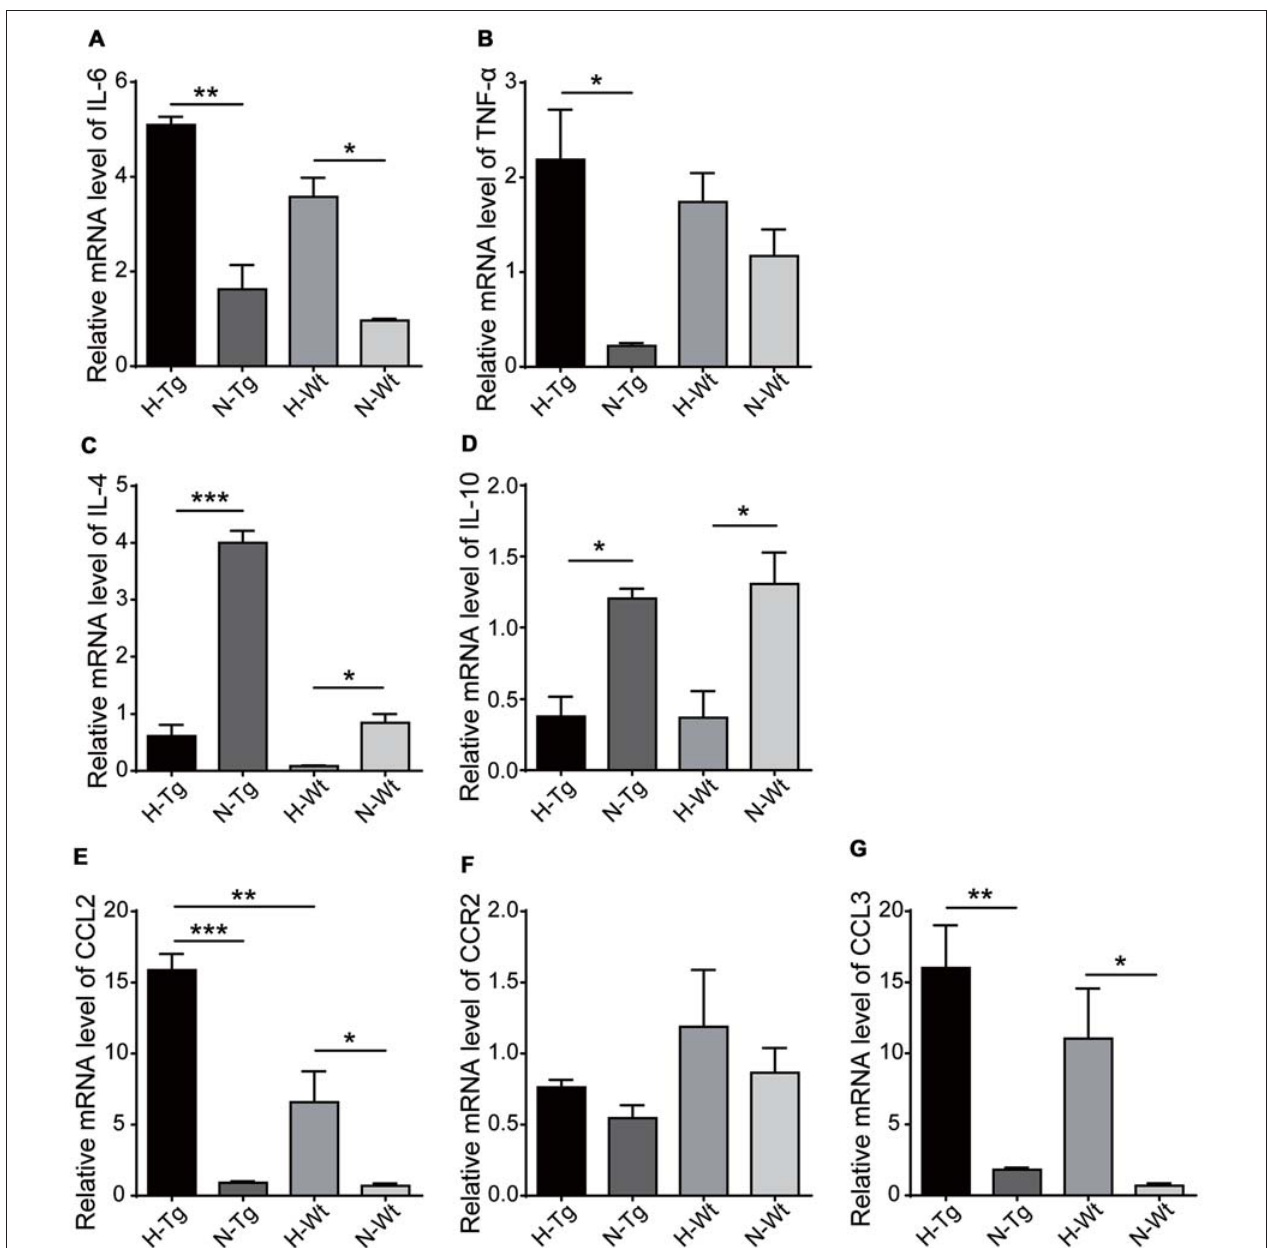
FIGURE 6 | mRNA levels of cytokines and chemokines were detected by real-time PCR in hippocampus after acute hypoxic treatment. Pro-inflammatory cytokines interleukin-6 (IL-6) (A) and tumor necrosis factor- α (TNF- α ) (B) increased in H-Tg group whilst anti-inflammatory cytokines IL-4 (C) and IL-10 (D) decreased in hypoxia groups. Chemokines C-C motif ligand 2 (CCL2) (E) and CCL3 (G) increased in hypoxia groups, whereas the change of C-C motif chemokine receptor 2 (CCR2) remained modest (F) . n = 4 in each group. Data were the mean ± SEM values. ∗ p < 0.05, ∗∗ p < 0.01, ∗∗∗ p < 0.001 by one-way ANOVA.